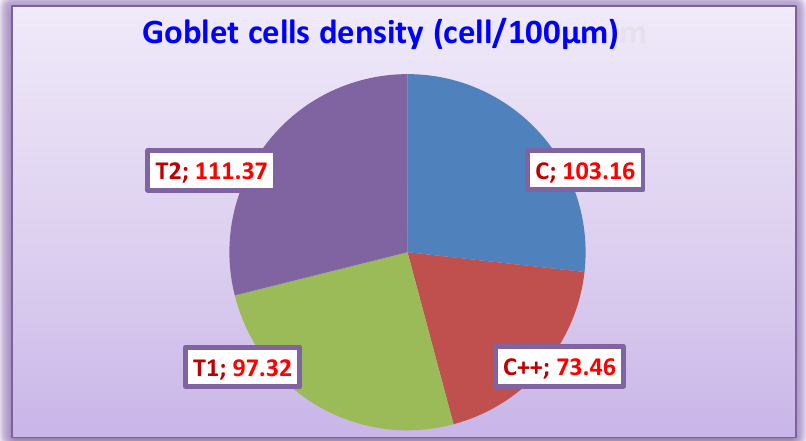
Figure 4B. Protective role of synbiotic on goblet cells density in duodenum (cell/100µm) against E. coli infection, N= 40 wells. Mean±SE. C: control negative group. C++: control positive group. T1: Fenugreek administered to enteritis group. T2: Fenugreek and L. acidophilus administered to enteritis group. Least Significant Difference (LSD) of goblet cell density =